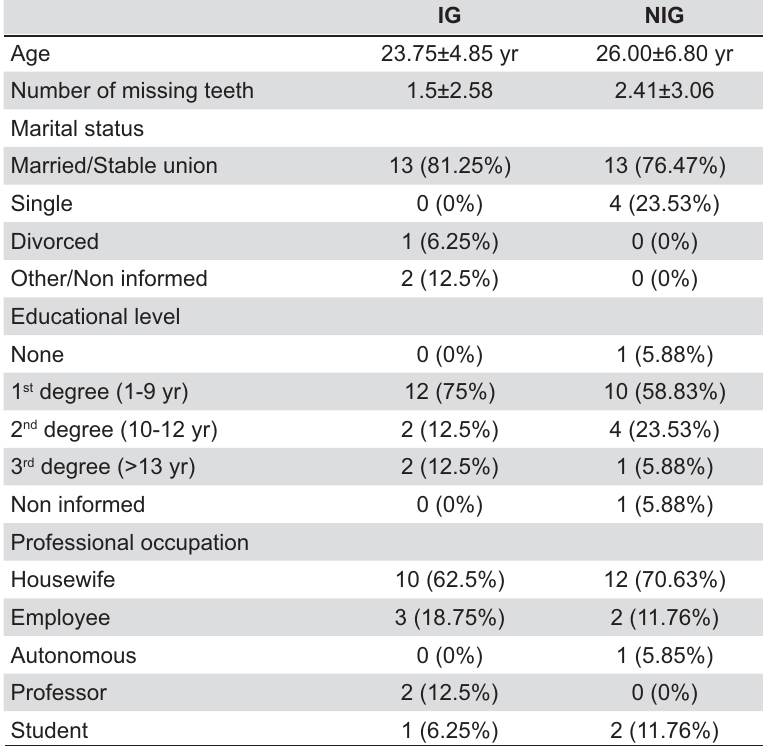
Table 1- Social, demographic and overall features of IG (intervention) and NIG (no intervention)